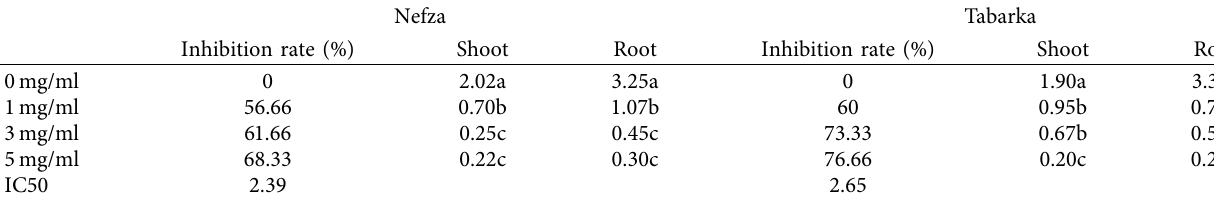
Table 10: Effect of ethanol extract on the germination of wild chicory